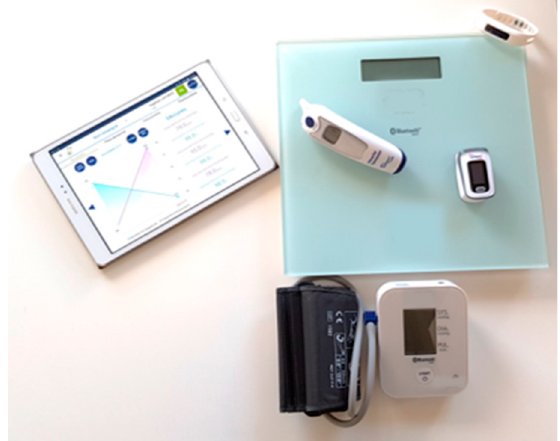
Figure 1. Devices used within the framework of the MyPredi™ platform [3].